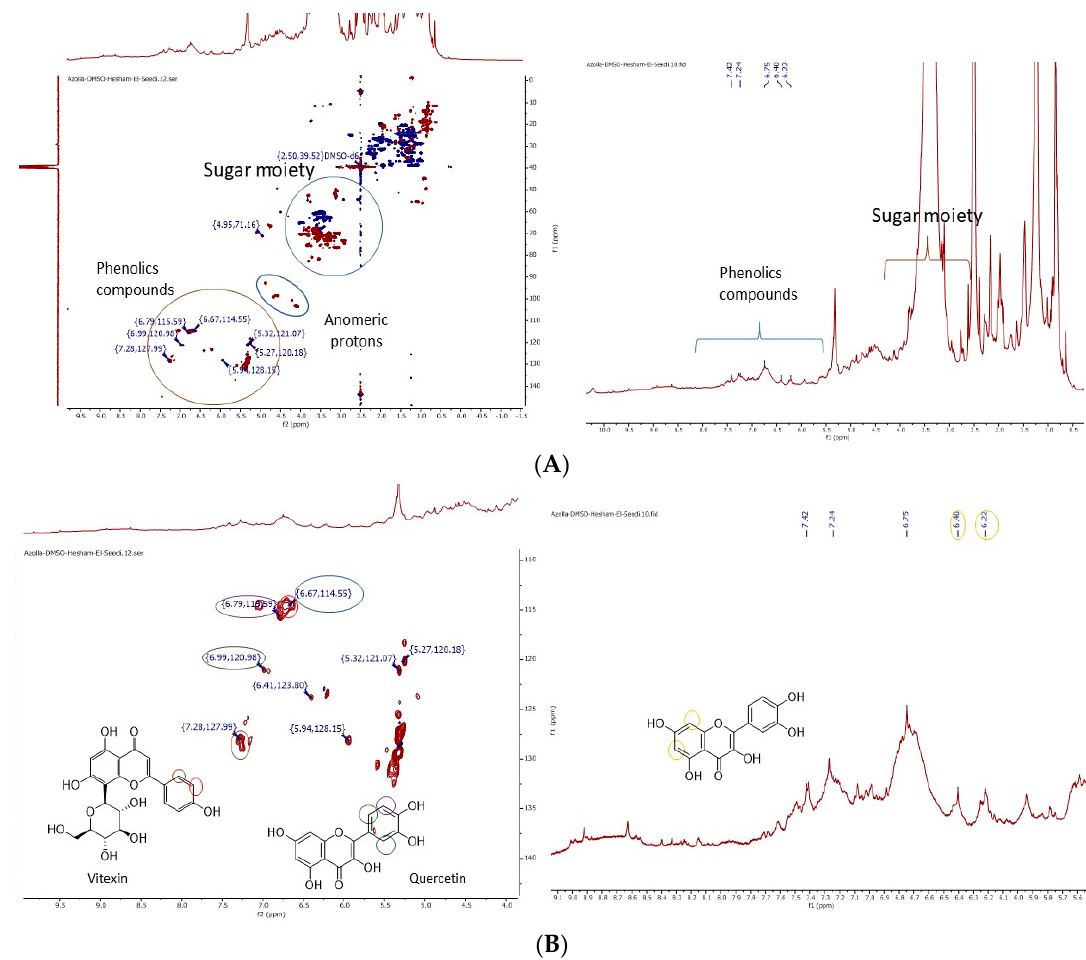
Figure 1. ( A ) 1 H-NMR and heteronuclear single quantum coherence spectroscopy (HSQC) spectrum of A. pinnata ethanolic extract. ( B ) 1 H-NMR and HSQC spectrum of A. pinnata ethanolic extract that prescribes the phenolic areas of quercetin and vitexin.